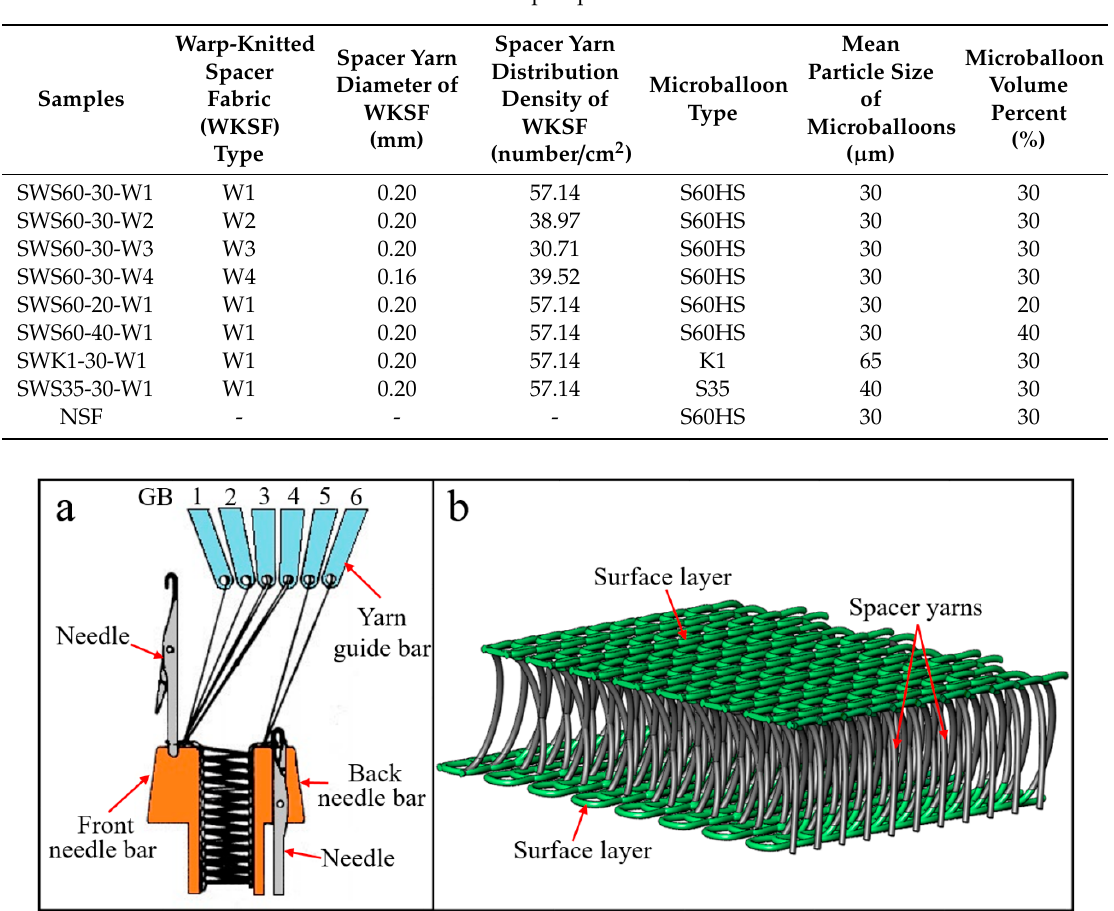
Table 1. Sample specifications.